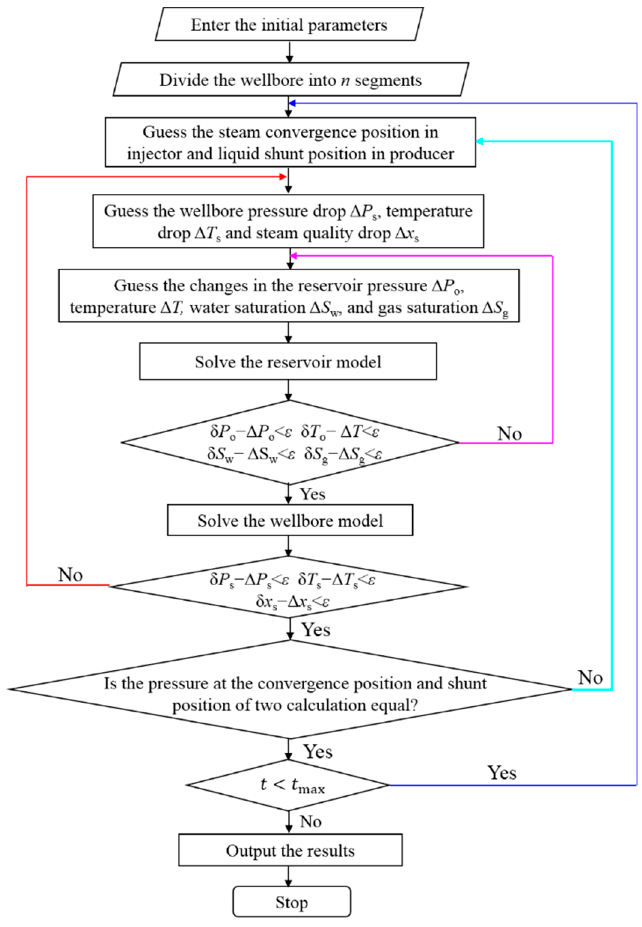
Figure 3. Calculation flow chart for the numerical model. Energies 2020 , 13 , x FOR PEER REVIEW